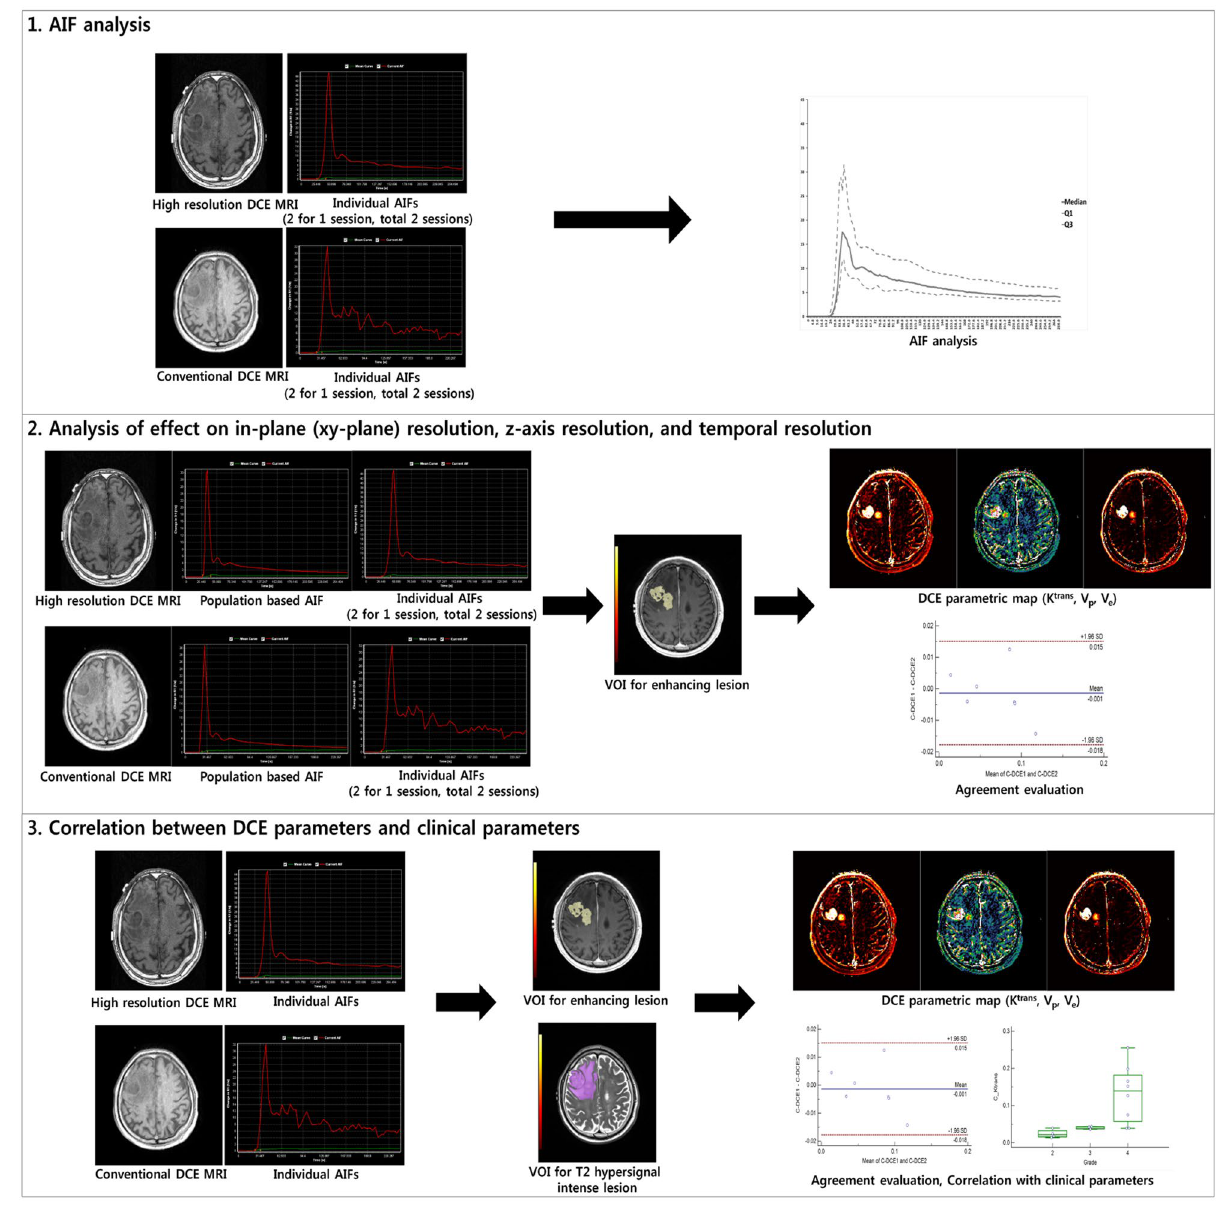
Figure 3. Study flow diagram. This study consists of (1) AIF analysis using individual AIFs, (2) analysis of the effect on in-plane (xy-plane) spatial resolution using population-based AIF, and the effect on the z-axis and temporal resolution using individual AIFs in patients with GBM, and (3) correlation between DCE parameters and clinical parameters using individual AIFs and VOIs for T2 hypersignal intense on a pixel-by-pixel basis. HR-DCE MR image analyses were performed in the same manner using postcontrast T1WI from navigation MR imaging and HR-DCE MR image DICOM files. After a month, AIF selections in two consecutive image planes were repeated to evaluate intraobserver repro- ducibility. Previously designated ROIs for enhancing lesions were reused to exclude the effect of ROI selection and assess interobserver reproducibility primarily arising from z-axis and temporal resolutions. DCE parametric maps and AIFs obtained from these measurements were used to evaluate the intraobserver reproducibility and AIF analysis. In addition, to evaluate the reproducibility originating from spatial resolution, DCE parametric maps using population-based AIF were generated to reduce the effect of AIF selection, and a second ROI for measurable enhancing foci was drawn for each patient. Using two individual ROIs and DCE parametric maps derived from population-based AIF, intraobserver reproducibility related to in-plane resolution was evaluated.